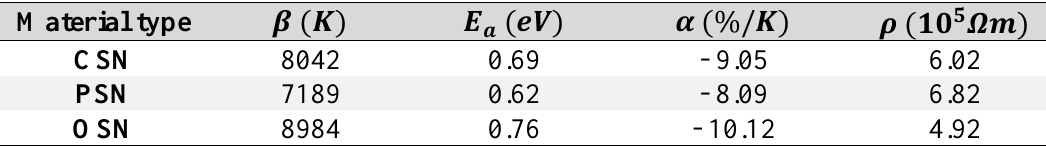
Table 5. Summary of electrical characteristics of the test